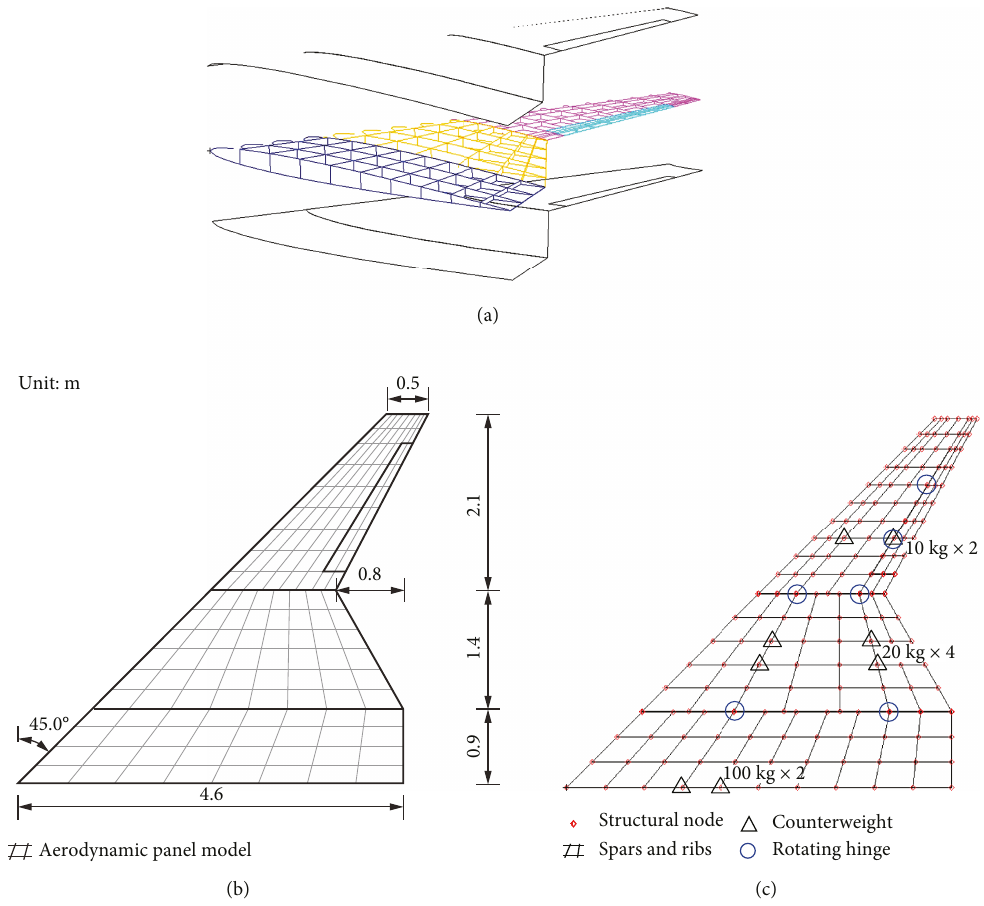
Figure 6: Geometries and dimensions of the folding wing aircraft. (a) Internal and external structure. (b) Aerodynamic panel model. (c) Structural model. Table 1: Main parameters of the